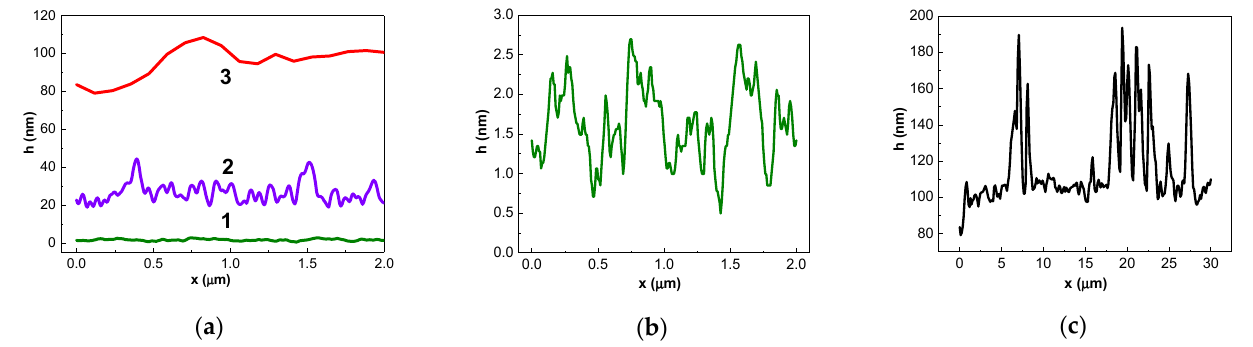
Figure 11. AFM profiles (scan of 2000 nm × 2000 nm) of the chip in accordance with the graphene surface treatment stages. ( a ) Profiles of the graphene surface treatment at different stages: curve 1— pristine graphene surface (stage 1); curve 2—after functionalization and immobilization of influenza B antibodies on the graphene surface (stage 2); curve 3—after functionalization, immobilization of influenza virus antibodies, and antibody–antigen virus B immunoreaction (stage 3). ( b ) Profile of the relief after stage 1 with a larger y-axis scale. ( c ) Profile of the relief after stage 3 with larger x- and y-axis scales.